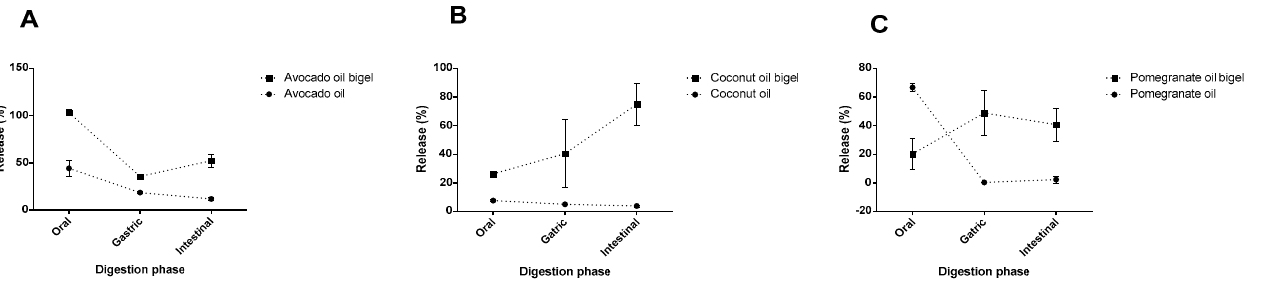
Figure 6. Evolution of main bioactive fatty acid release (%) during gastrointestinal digestion. ( A ) avocado oil and correspondent bigel, ( B ) coconut oil and coconut oil bigel, and ( C ) pomegranate oil and correspondent bigel.